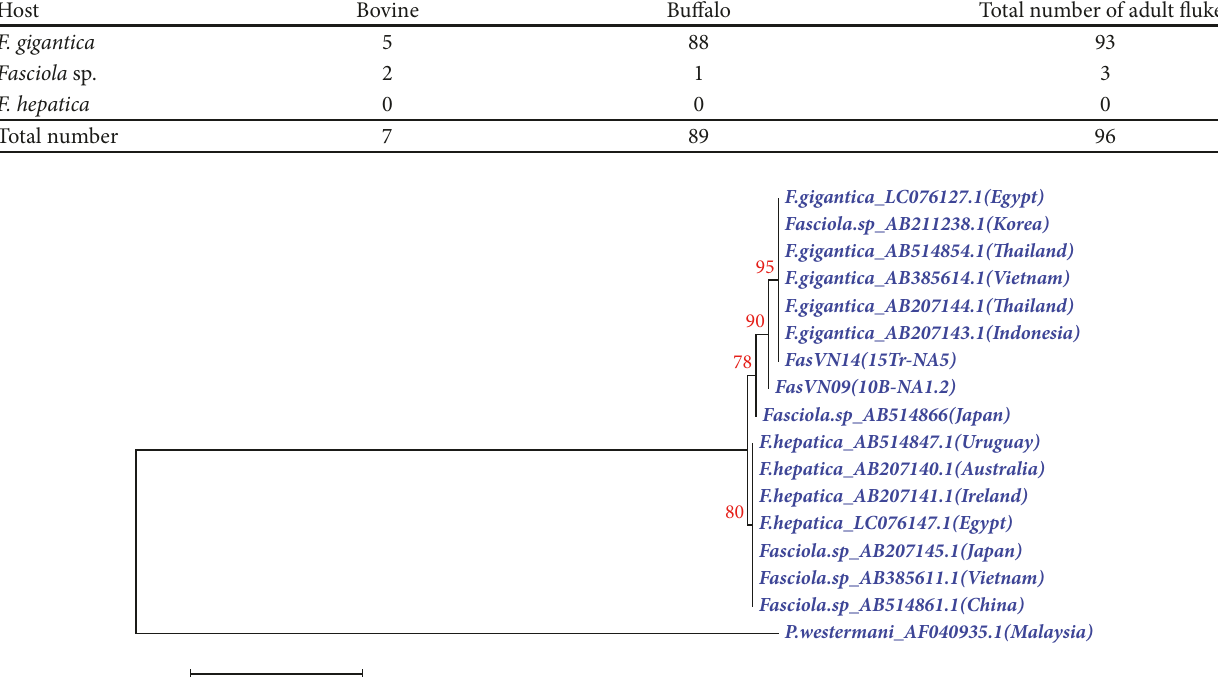
Figure 4: Phylogenetic relationship of ITS1 sequences of Fasciola from Vietnam using Neighbor-Joining Tree method. Paragonimus westermani (AF040935.1) was used as the